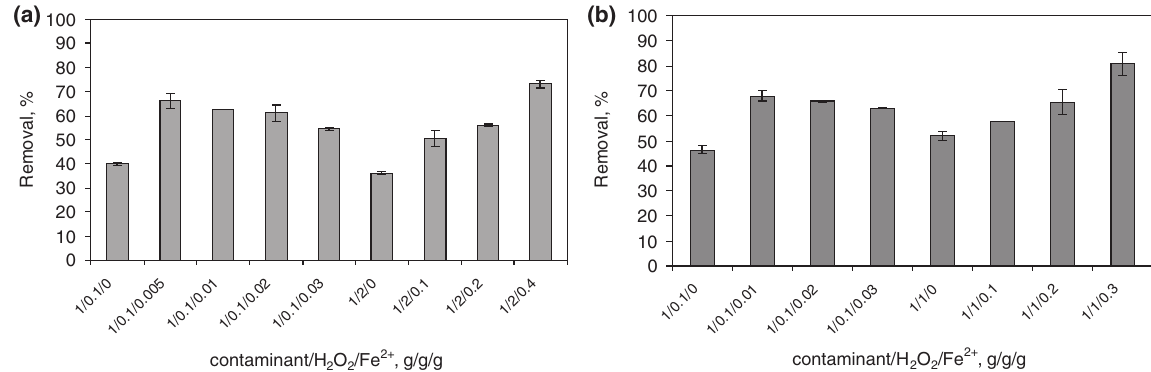
Fig. 2. Total contaminant removal (% of initial content) in the soil after a 24-h treatment with a) hydrogen peroxide and b) percarbonate, with and without the addition of supplemental ferrous iron, at different weight ratios of contaminant-to-H 2 O 2 . The error bars represent the standard deviation of the replicates (n (cid:30) 3)